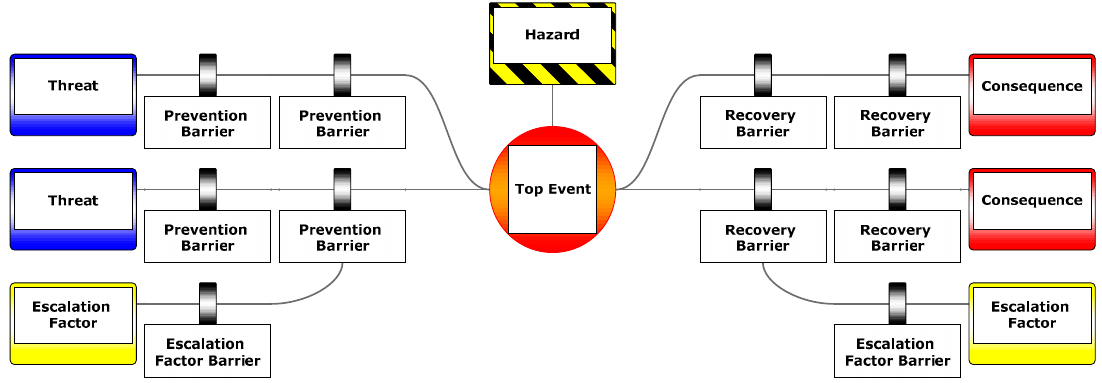
Figure 1. Schematic Bowtie diagram with prevention and recovery barriers.